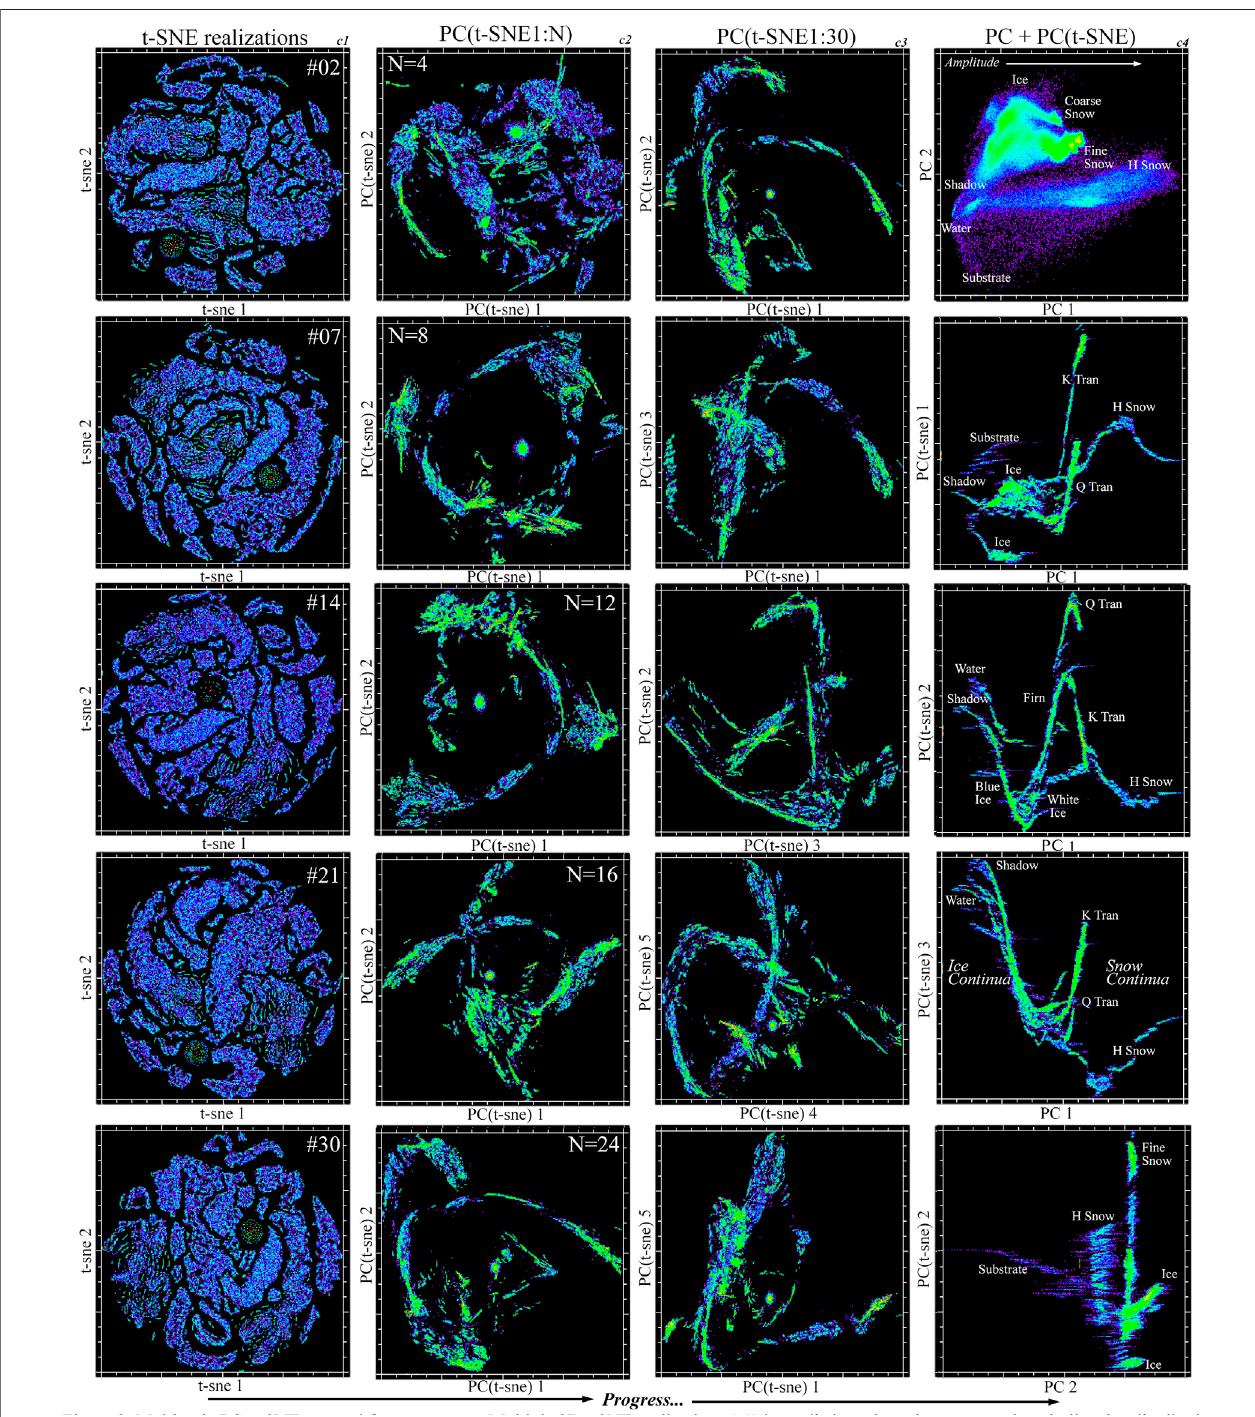
FIGURE3| MultiscalePC+t-SNEspectralfeaturespaces.Multiple2Dt-SNErealizations(c1)havedistinctclusteringpatterns,butsimilarsizedistributions.PCsof increasingnumbersof2Dt-SNErealizations(c2)showprogressivecoalescenceintosmallernumbersofdistinctelongatemanifolds.ProjectionsofloworderPCsfroma set of 30 2D t-SNE realizations (c3) maintain this elongate manifold structure although clusters become more dispersed in higher order PCs. Joint PC + PC(t-SNE) characterization (c4)combinestheglobalspectralcontinuaofthePCfeaturespace( Figure2 )withthelocalclusteringofthe2Dt-SNEfeaturespacesaccentuated intheloworderPCsof30t-SNErealizations.Thet-SNEmanifoldcontinuitypersists,butcanbeinterpretedintermsoftheglobalcontinuaofspectralpropertiesre fl ected in the topology of the PC space. The perplexity of the t-SNE realizations is 30 in all cases.